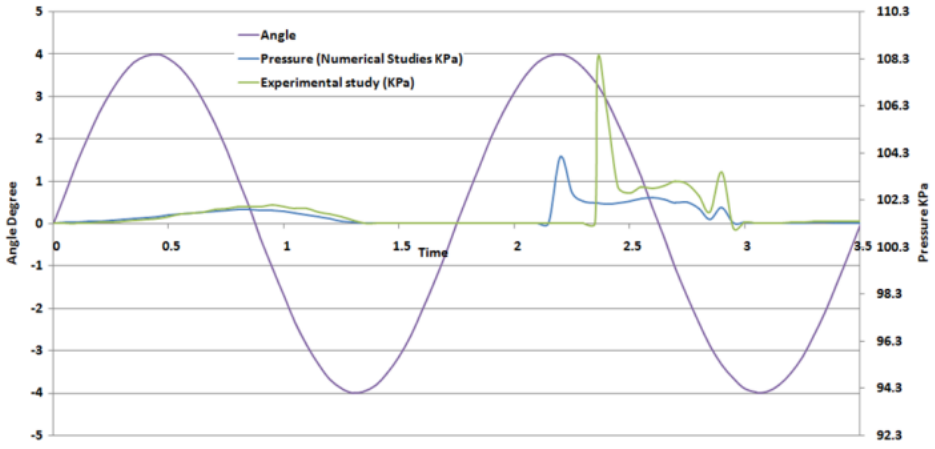
Figure 6. Pressure comparison (experimental vs. numerical).